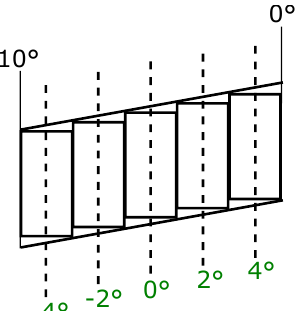
Figure 17. Step-skewing simulation conditions.